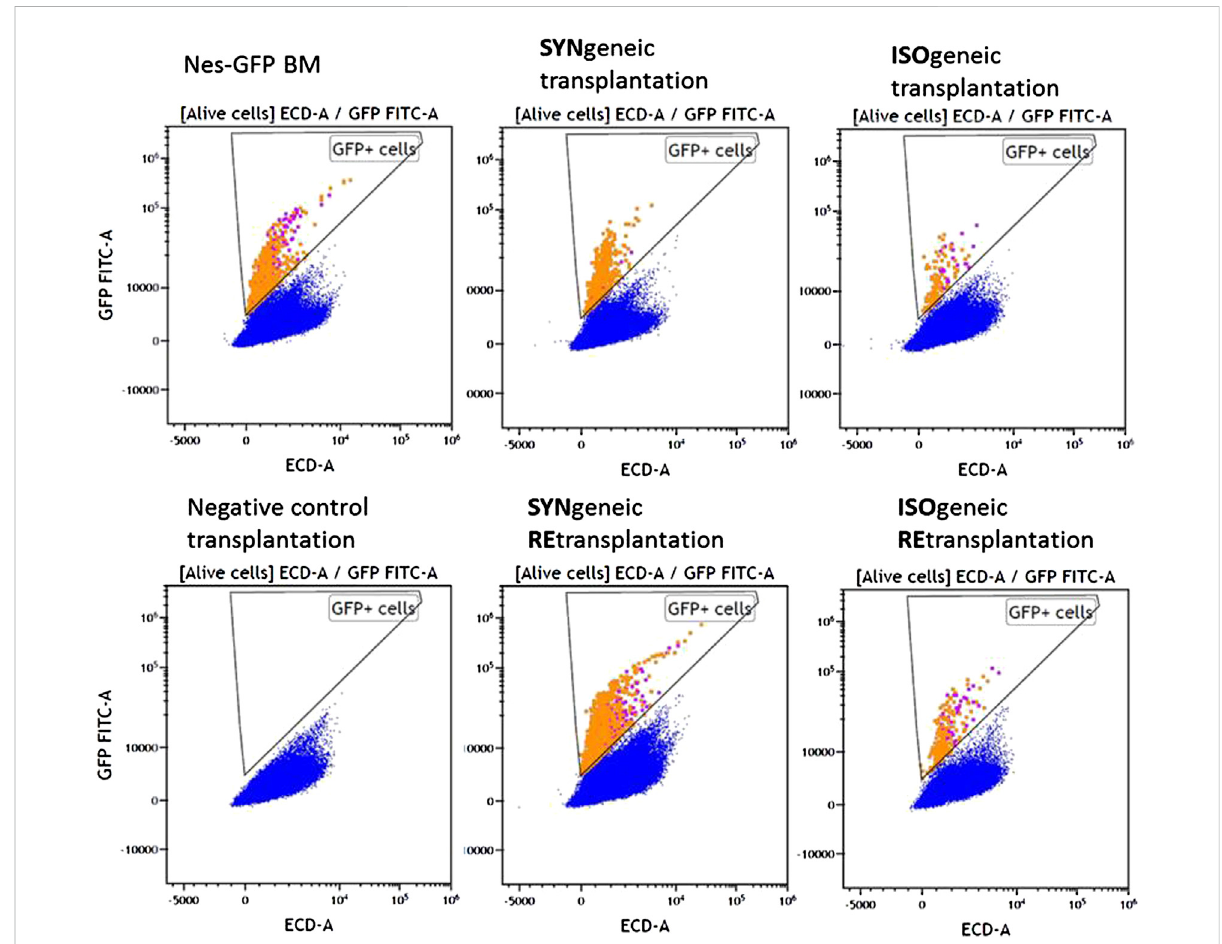
FIGURE 3 MFC data for representative samples of experimental groups. Alive nucleated cells. Orange and purple dots correspond to GFP + CD45 + and GFP + CD45 – cells, respectively.